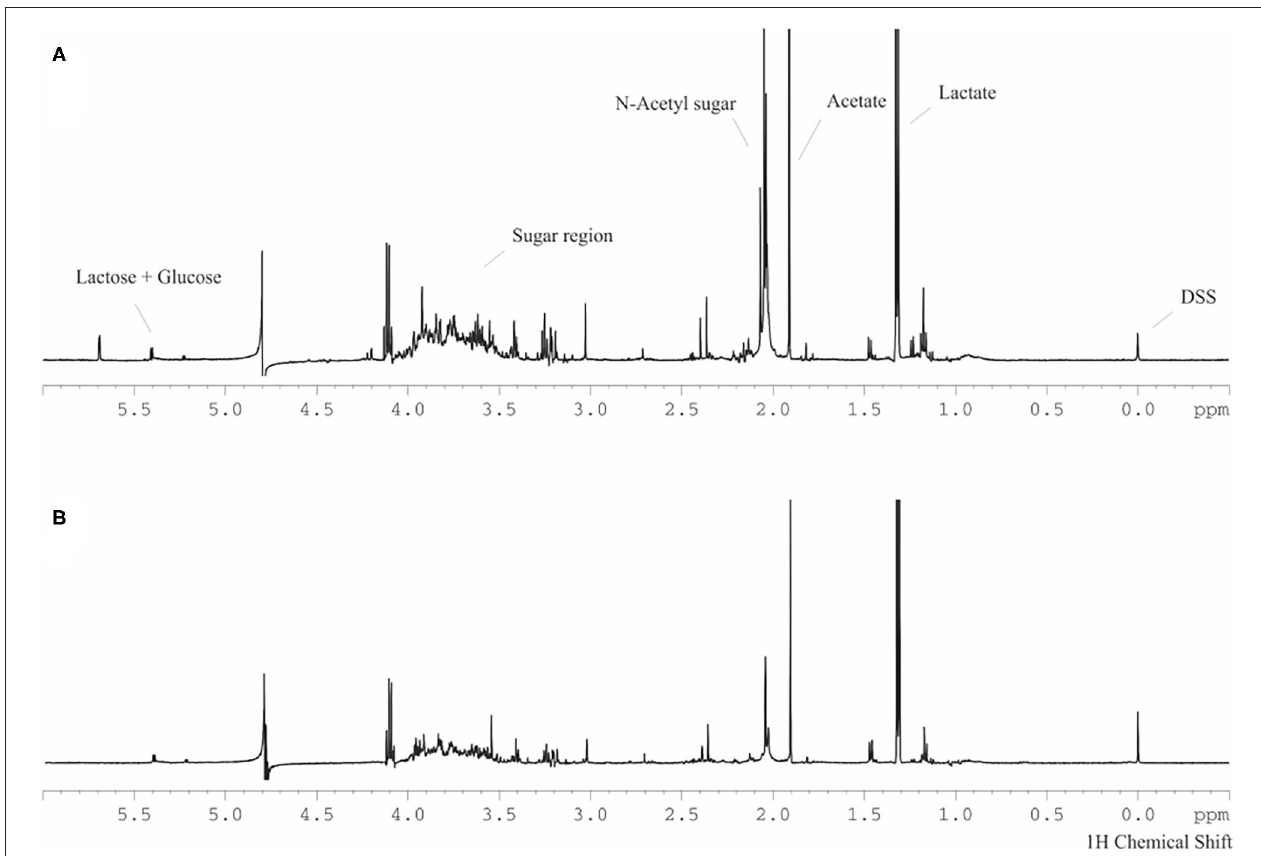
FIGURE 4 | Representative spectrum of ¹H NMR of whole saliva from infants in the pre-dental period with mixed feeding (consumption of breast and artificial milk) before (A) and after performing oral hygiene procedures (B)